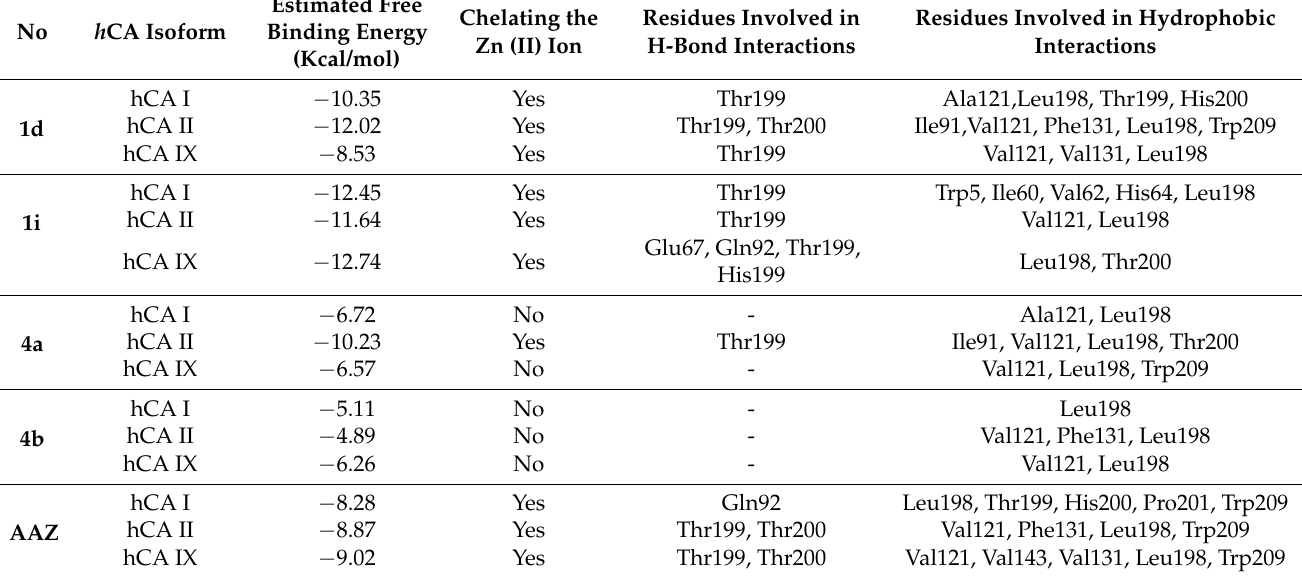
Table 3. Molecular docking free binding energies (kcal/mol) and interactions of tested compounds on hCA I, II and IX